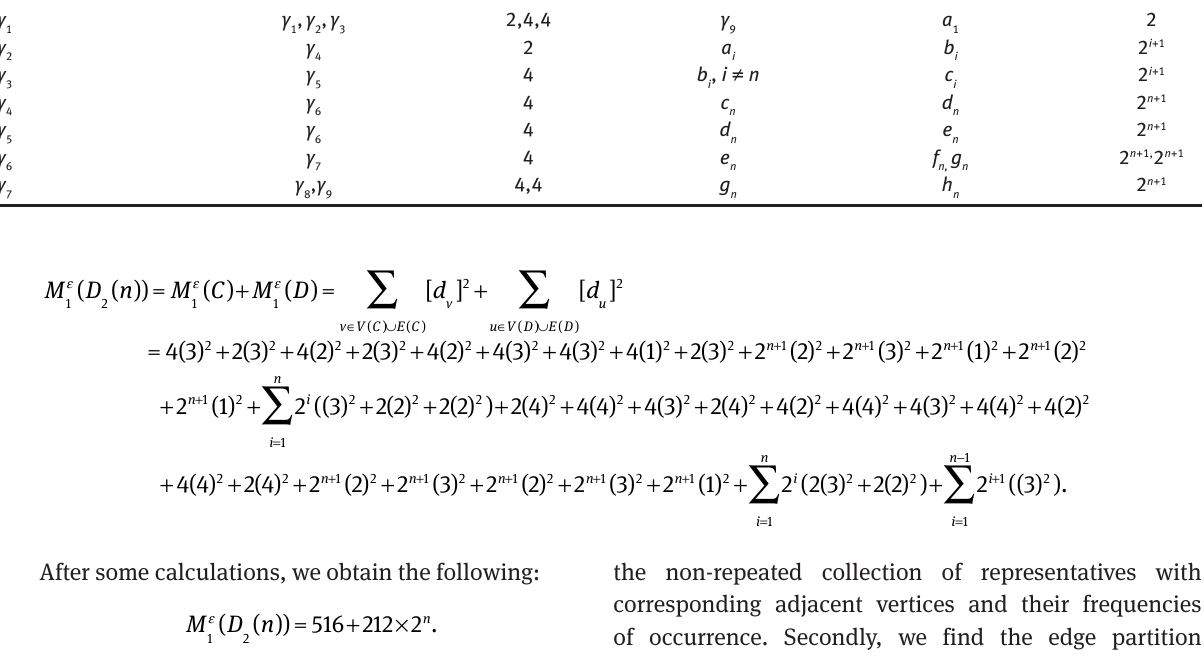
Table 8: Representatives with corresponding adjacent vertices and their frequencies of occurrence for n ≥ 1. Representatives